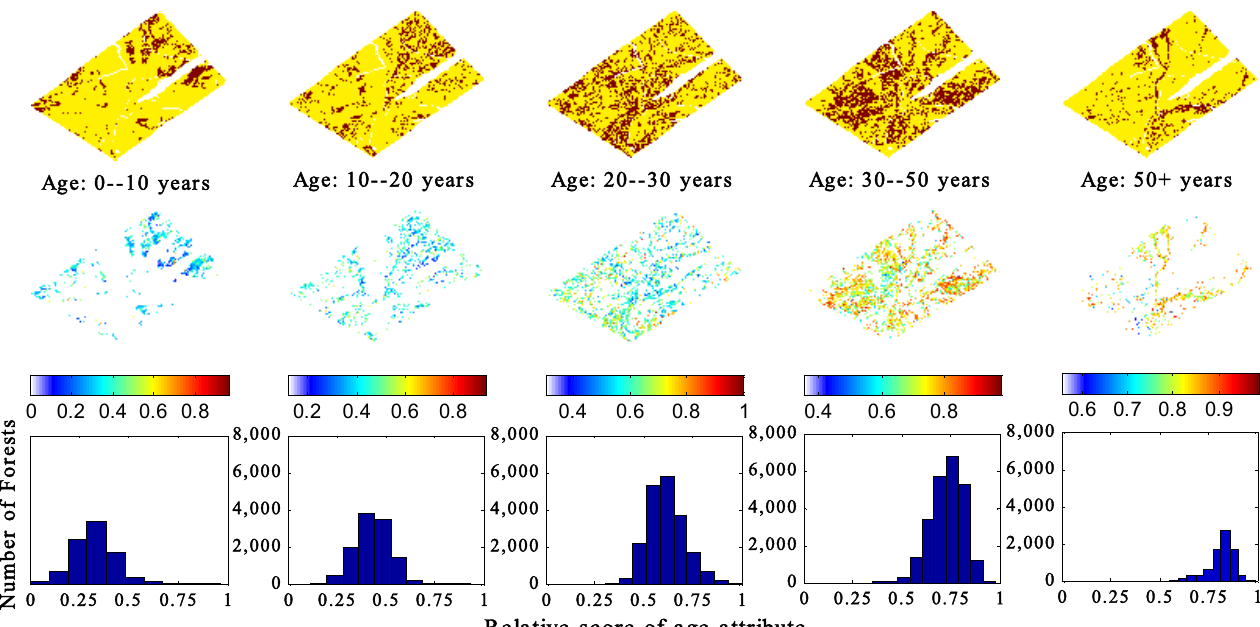
Figure 11. Comparison and statistics between the age groups and age attribute. Upper row: the dark red areas in each subfigure represent the distribution of forests in the corresponding age group. Middle row: the age-attribute scores shown in a spatial context and scaled to range from 0 to 1.0 (0: young forest, 1: old forest). Lower row: the number of forests as a function of the relative scores of the age attribute.